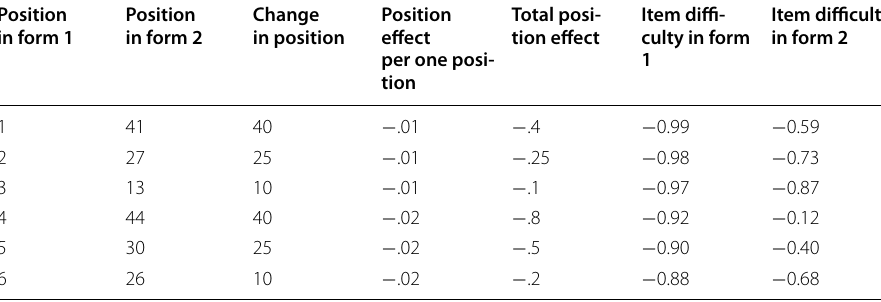
Change in position